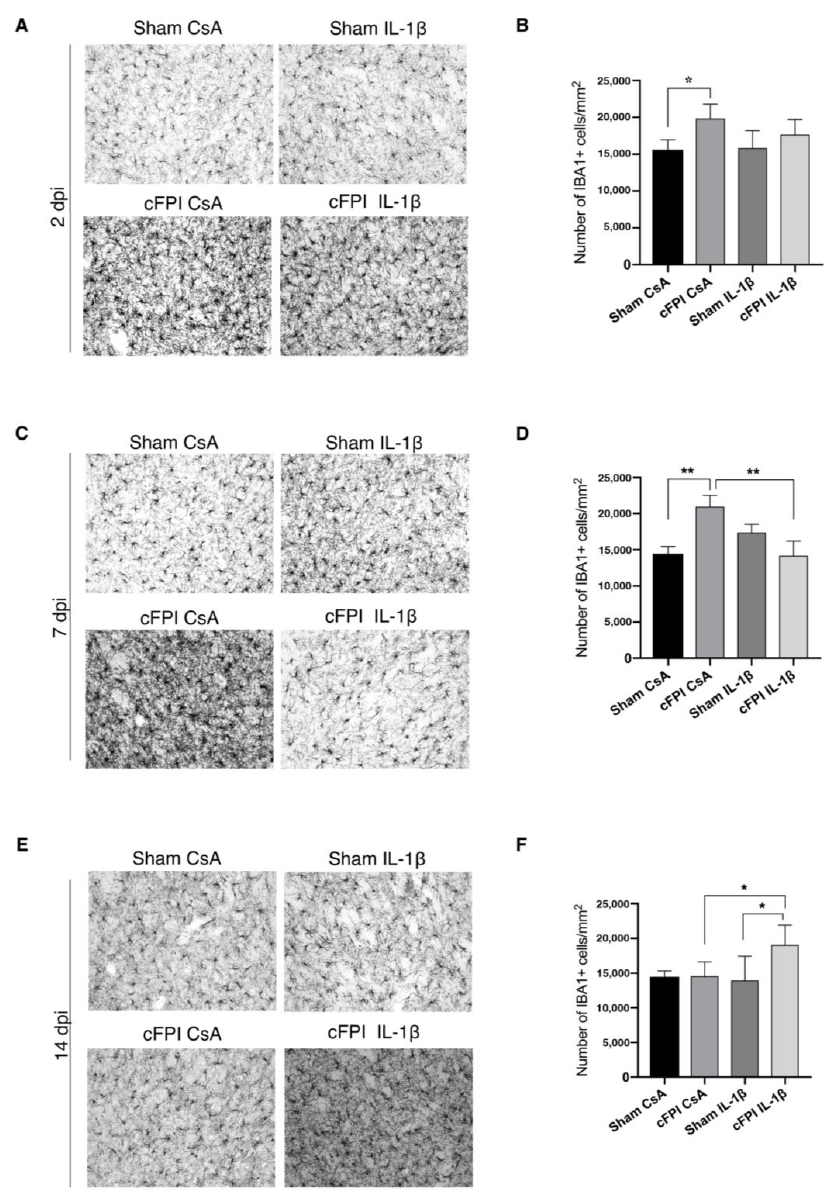
Figure 1. IL-1 β neutralization attenuates the increase of Iba1 + microglia cells in the globus pallidus. Figure 1. IL-1β neutralization attenuates the increase of Iba1+ microglia cells in the globus pallidus. Compared with sham CsA mice at two dpi, ( A , B ) the number of Iba1+ cells was increased in CsA cFPI Compared with sham CsA mice at two dpi, ( A , B ) the number of Iba1 + cells was increased in CsA animals (sham CsA, n = 4; sham IL-1β, n = 3; cFPI CsA, n = 6; cFPI IL-1β, n = 6; * p ≤ 0.05), while neutralizing IL-1 β had no effect on the number of Iba1+ microglial cells. At two dpi, Iba1 positive microglia processes were thin and ramified in the sham CsA group compared with thicker processes in the cFPI CsA animals ( C , D ) At seven dpi, the increase in the number of Iba1+ microglia cells persisted in the cFPI CsA animals compared with sham groups, which was significantly reduced by IL-1β neutralizing antibody treatment (sham CsA, n = 4 sham IL-1β, n = 3; cFPI CsA, n = 7; cFPI IL-1β, n = 6; ** p ≤ 0.01). Iba-1 positive microglia had thin and ramified processes in the cFPI IL-1β animals similar to sham CsA group ( E , F ) At 14 dpi, no difference was observed in the number of Iba1 positive microglia cells in the cFPI CsA animals in comparison to the sham groups (sham CsA and sham IL-